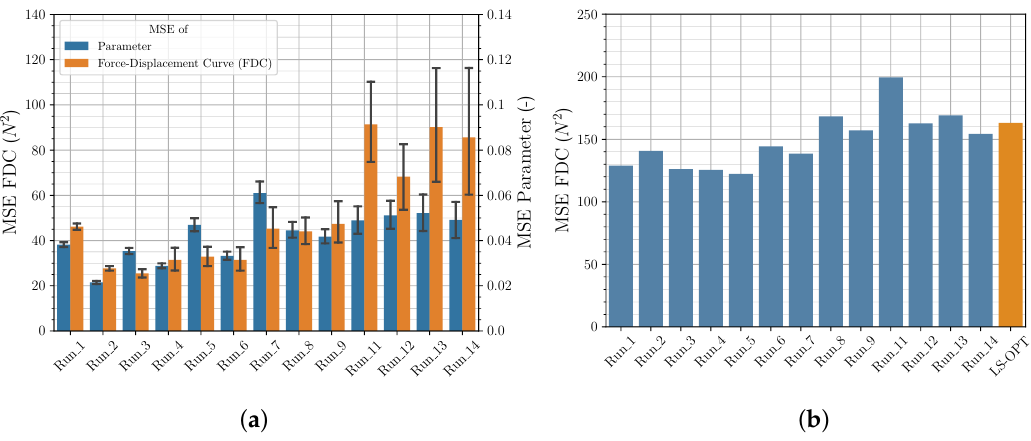
Figure 7. Sampling strategy and quantity of input data—comparison of MSE of material parameter and FDC from ( a ) validation data and ( b ) experimental